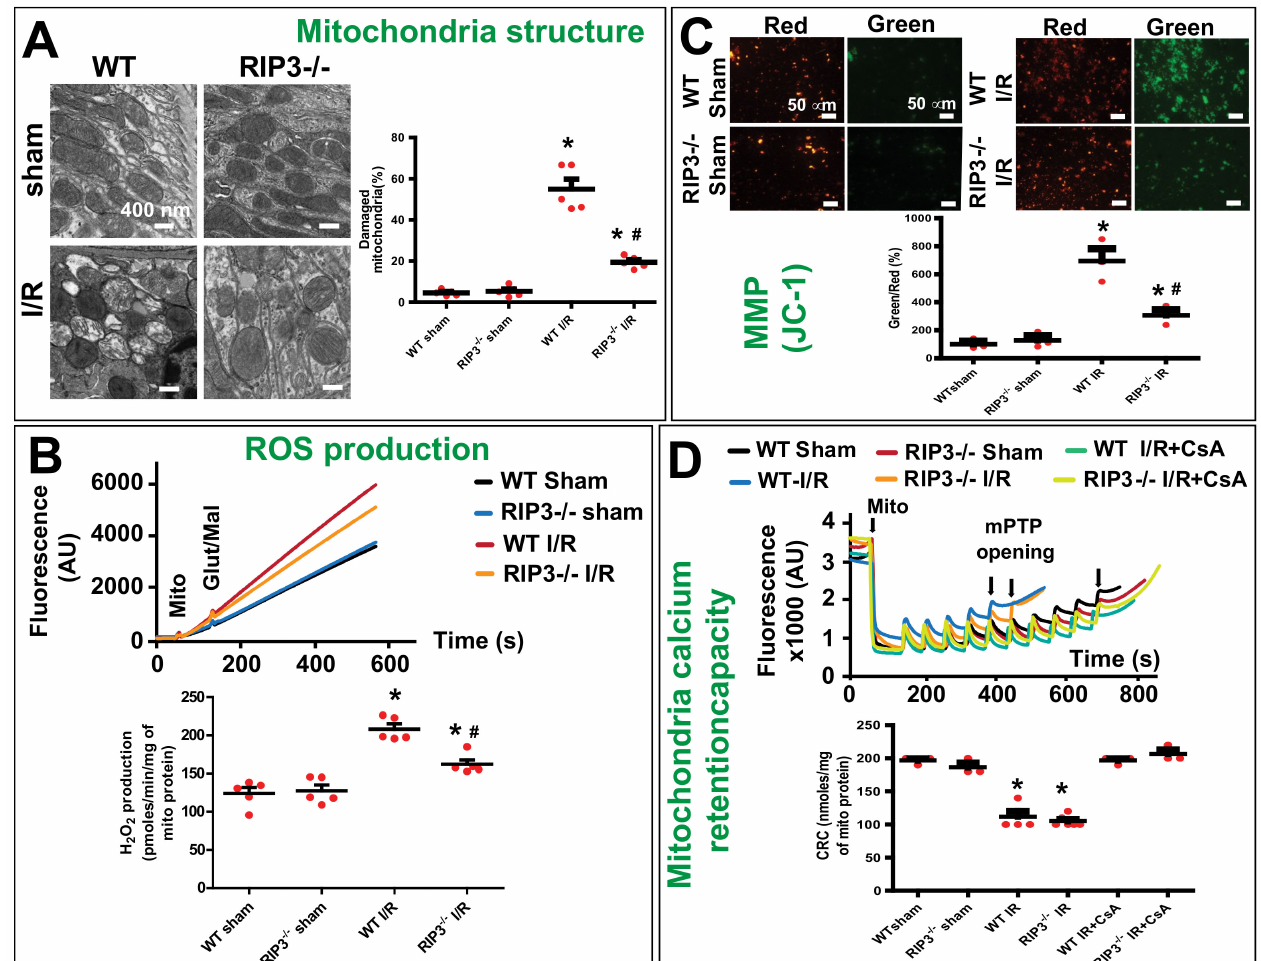
Figure 5. RIP3 knockout protects against mitochondrial damage and dysfunction after renal